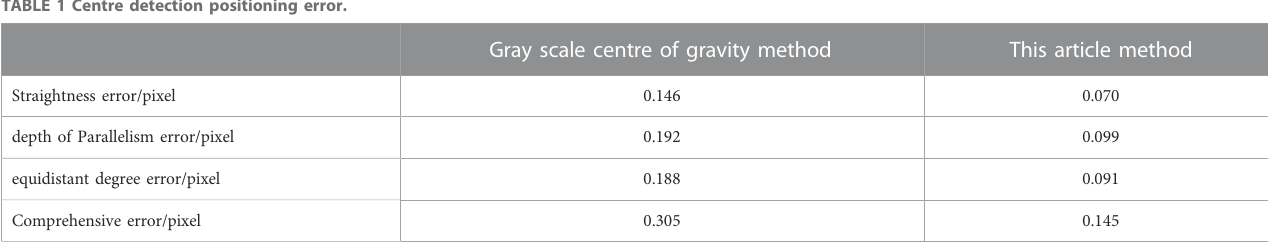
TABLE 1 Centre detection positioning